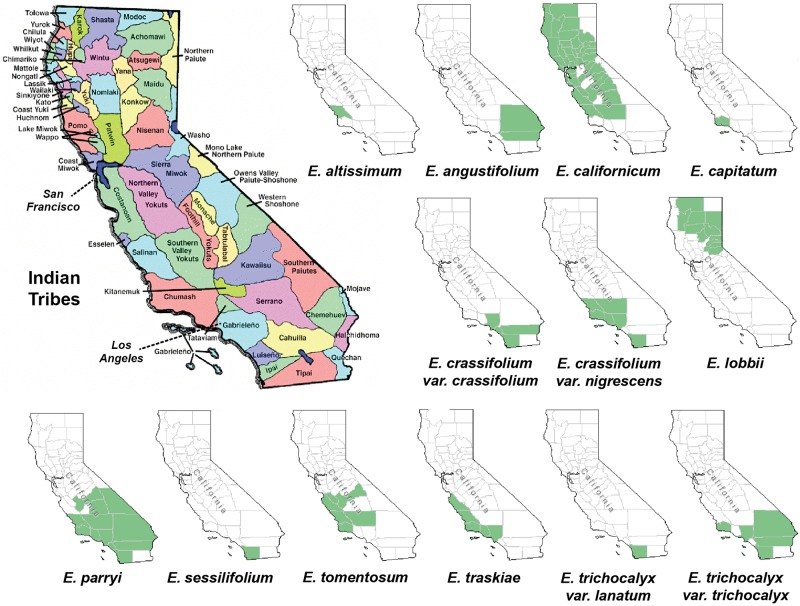
Maps of California depicting the Indian tribal territories (large map on the left) and the geographic distribution of each of the Eriodictyon species and infraspecies studied (green in smaller maps). Sources: California Indian Library Collections and United States Department of Agriculture, Natural Resources Conservation Service (USDA, NRCS) (https://plants.sc.egov.usda.gov/).